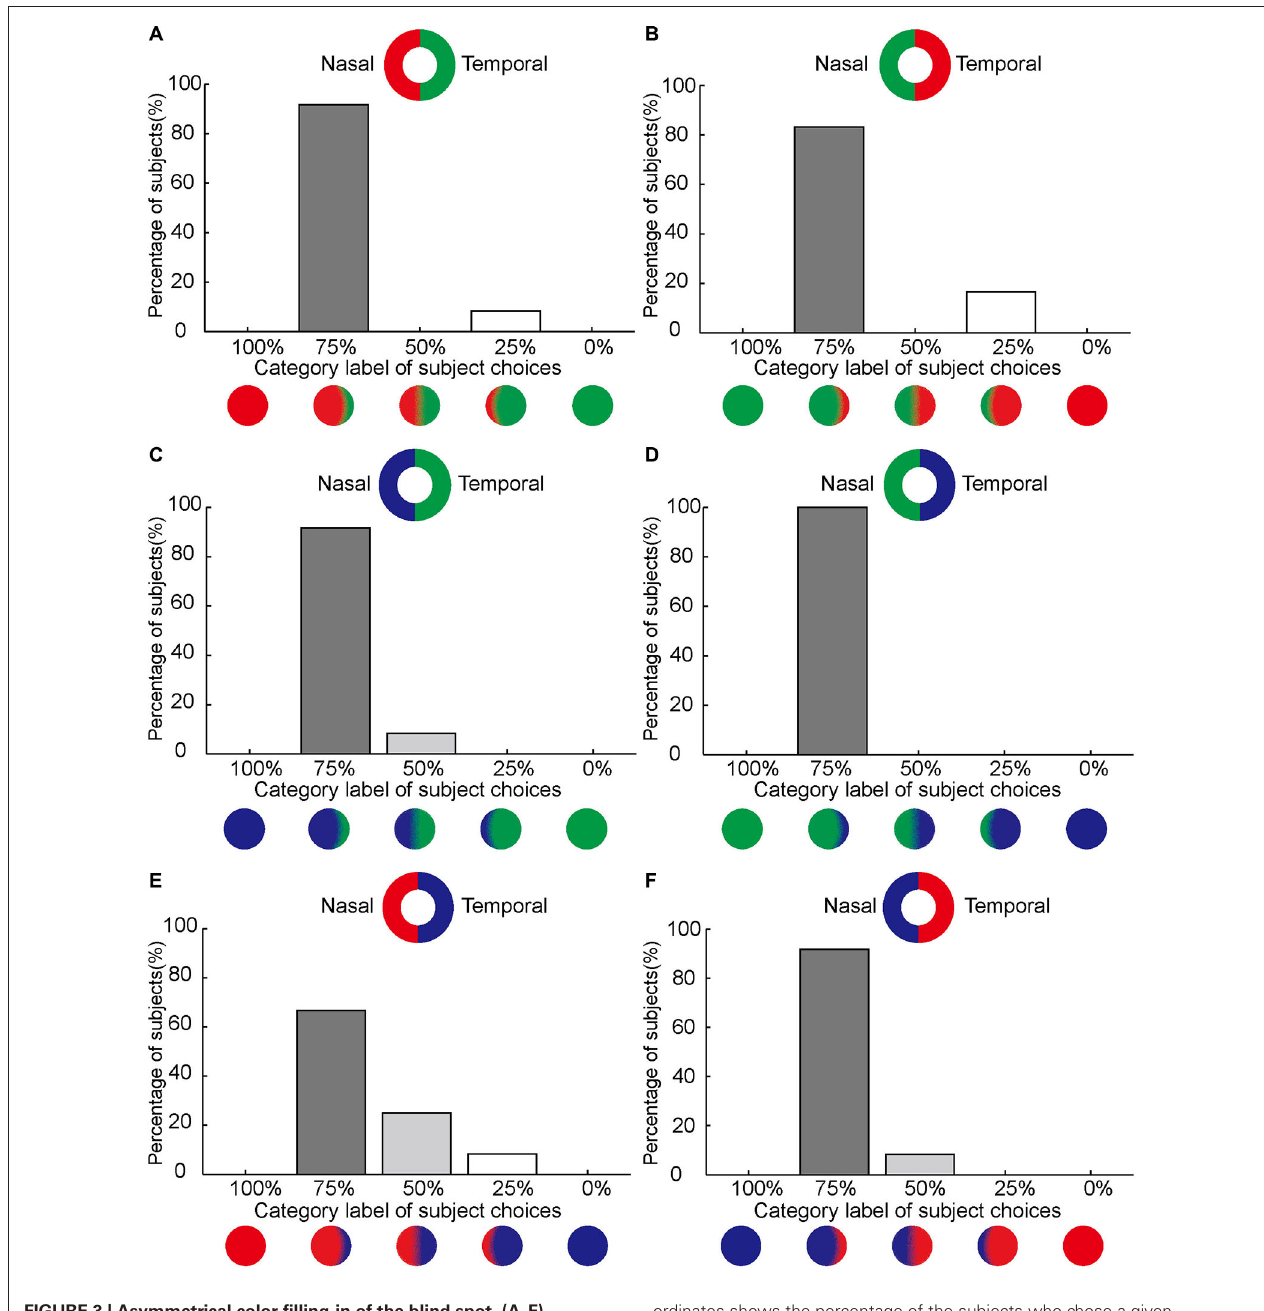
FIGURE 3 | Asymmetrical color filling-in of the blind spot. (A–F) Demonstrate that color on the nasal side of the blind spot area dominates the filling-in with subjects typically choosing the 75% category label. The axis along the abscissas illustrates the category label of subject choices corresponding to the option panel shown in Figure 1 (see Section Materials and Methods). The axis along the